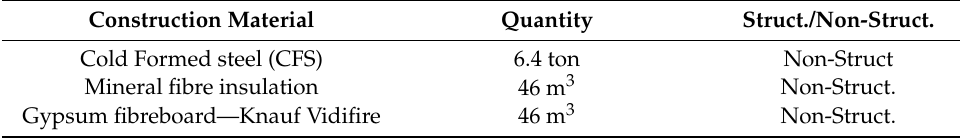
Table 6. Bill of materials: non load bearing walls.